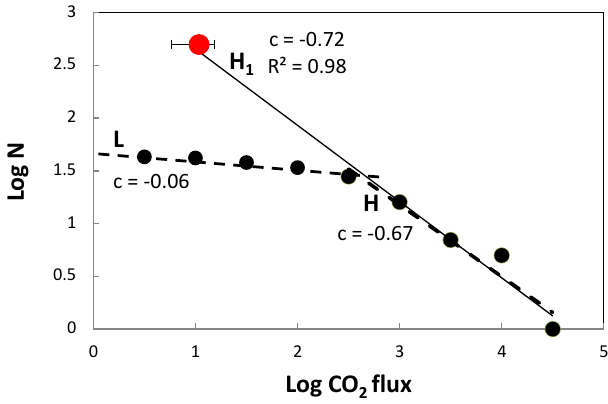
Figure 9. Cumulative frequency of the number of volcanoes ( N ) emitting CO 2 flux (logarithmic scale). The diagram is based on the data set of Burton et al. (2013), implemented with new results from this study and additional data (see text). The red point, with co- ordinates log f = 1 (CO 2 flux = 10td − 1 ) and log N = 2 . 69 (500 volcanoes), lies right above the linear regression line of the high CO 2 flux (log f > 2.5) population (dashed line H). The regression line (line H 1 ; R 2 = 0 . 98) is obtained considering the high CO 2 flux volcanoes (log f ≥ 2 . 5) plus this new log f = 1